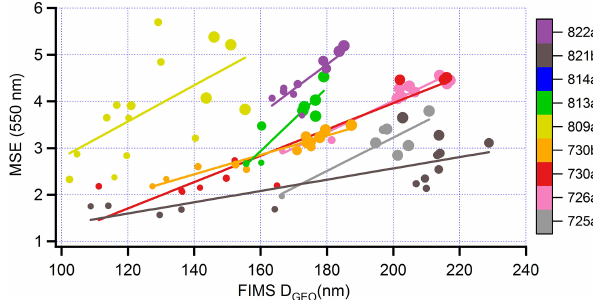
Figure 16. Mass scattering efficiency (m 2 g − 1 ) as a function of D GEO . Format similar to Fig.